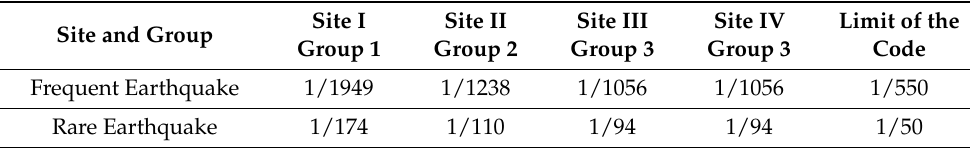
Table 5. Max story drift angles obtained by the response spectrum